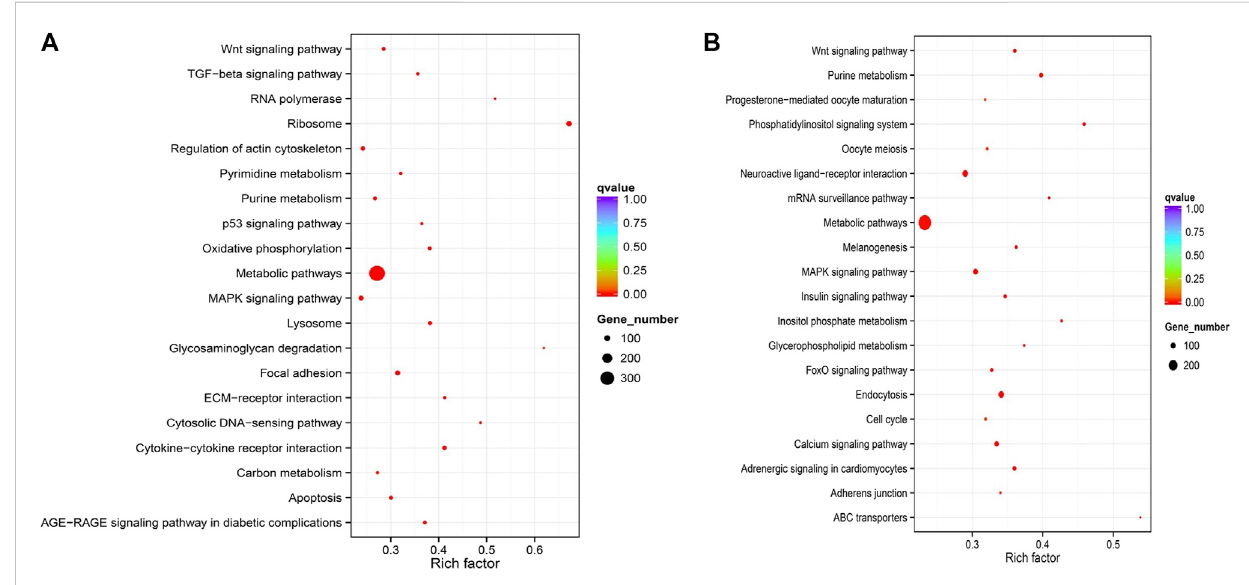
FIGURE 3 Top20 KEGG pathways enrichment of upregulated DEGs (Ovary vs Testis) (A) and downregulated DEGs (Ovary vs Testis) (B)